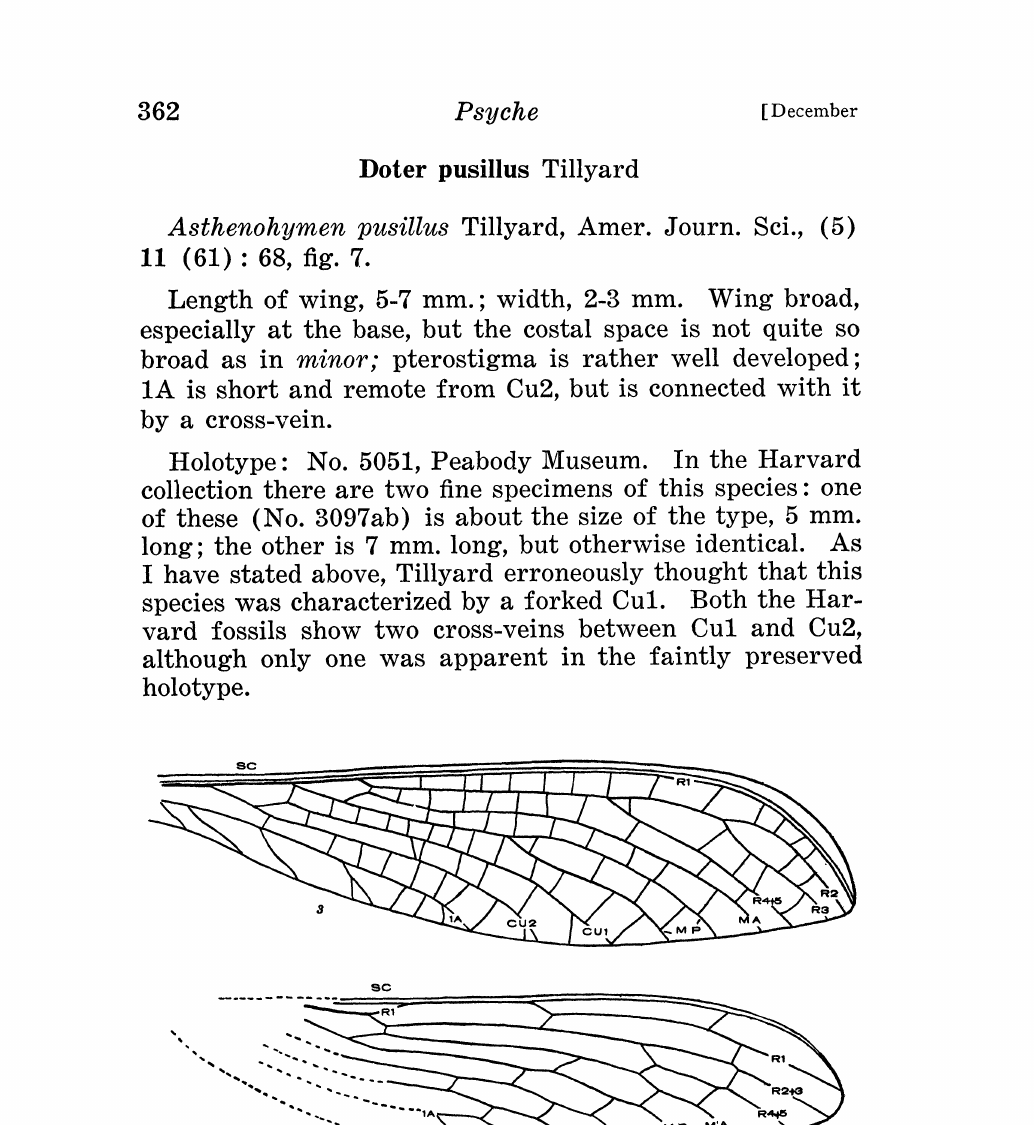
FIG. 3. Fore wing of .Aspidohymen triangularis Brogn., from the Carboniferous of France (after Brongniart). FIG. 4. Wing (hind?) of Aspidohymen extensus Mart., from Russian Permian (after